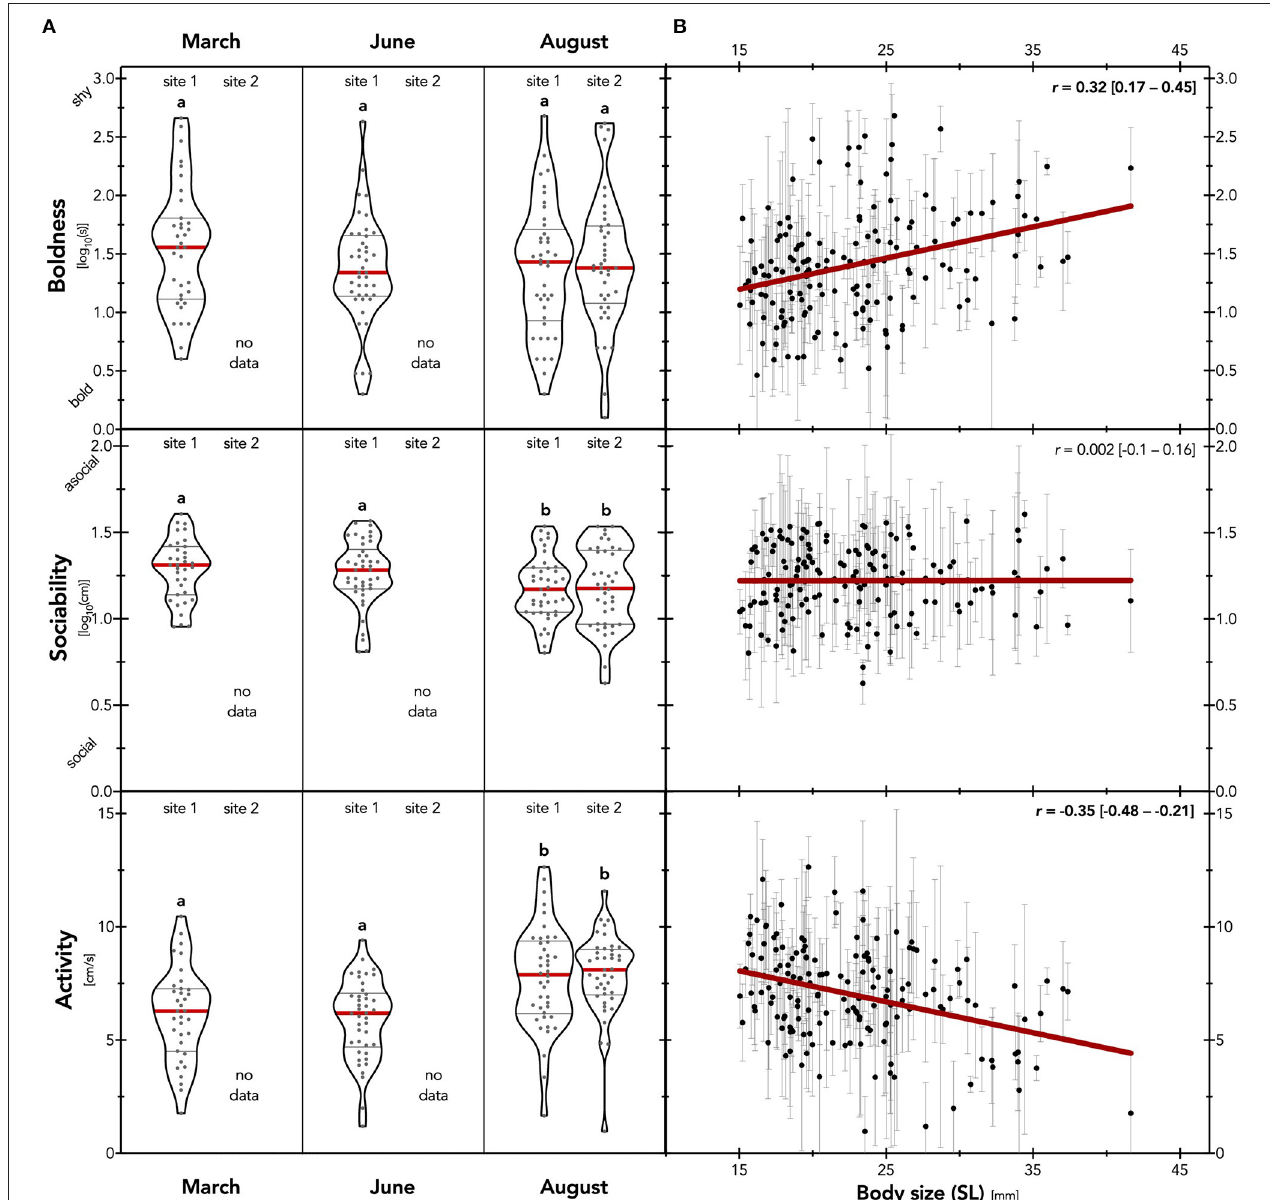
FIGURE 3 | Average personality traits across temporal and spatial scale. (A) Mean trait scores (median ± IQR) for boldness (i.e., time to emerge from shelter), activity (i.e., velocity during open field exploration) and sociability (i.e., distance to biomimetic robot). Different letters depict significant differences based on post-hoc LSD tests after global linear mixed models ( p < 0.05). ( B ) Mean trait scores ( ± SD) in relation to body size (standard length; n = 159). To visualize the relationships, we show linear regressions (red line) calculated from individual means (parameters significantly different from zero at the 95% confidence level are indicated in bold; see main text for detailed analysis). Note that low scores of boldness and sociability indicate high trait expression.